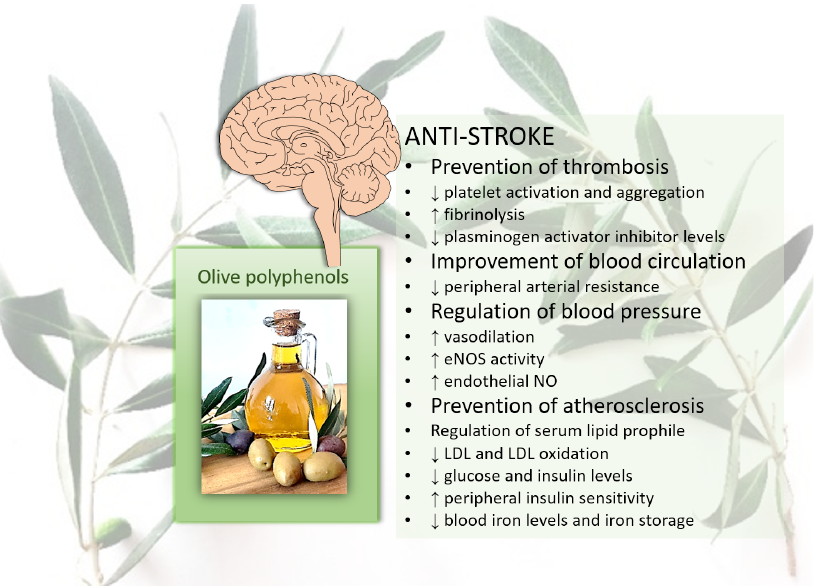
Figure 2. Main anti-stroke effects of olive polyphenols. ↑ , increases; ↓ , decreases; eNOS, endothelial nitric oxide synthase; NO, nitric oxide; LDL, low-density